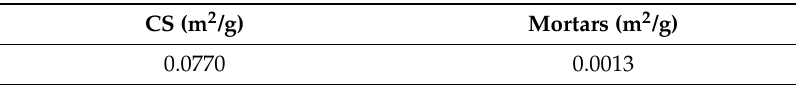
Table 3. BET results of CS and mortars.